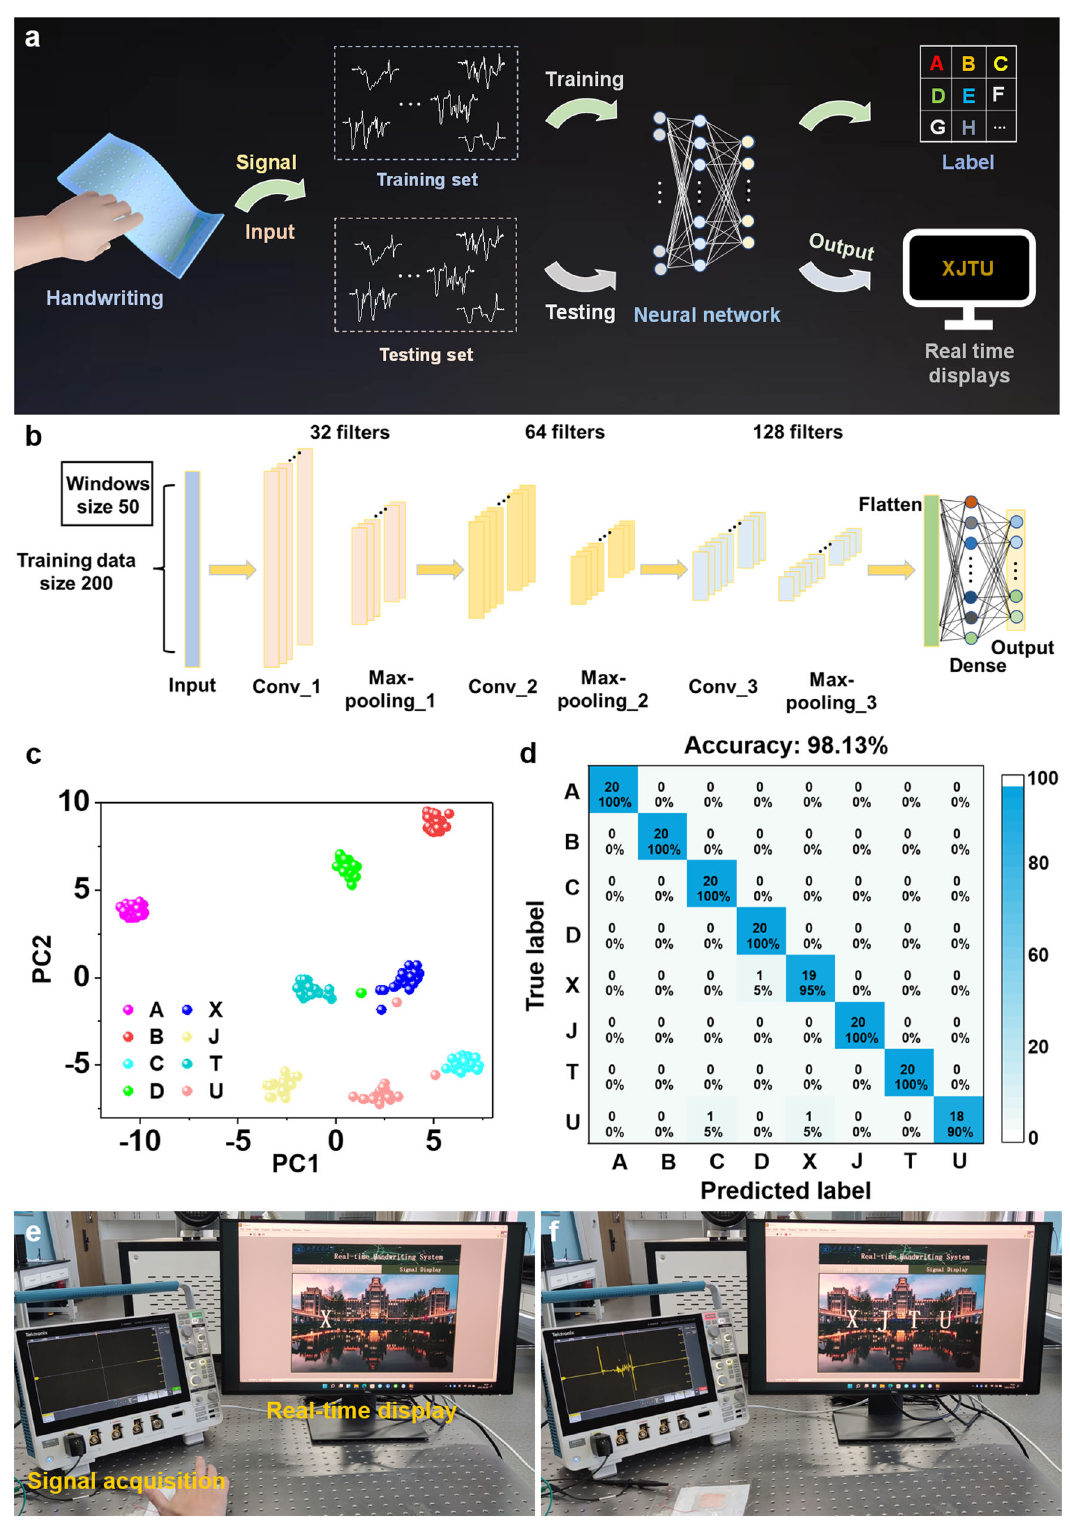
Fig. 5 Real-time handwriting system based on deep learning. a Flow-process diagram of the real-time handwriting system. b The detailed process and parameters of a CNN model. c Clustering results after processing the voltage signal of “ A, B, C, D, X, J, T, U ” by CNN model. d Confusion map of recognizing 8 letters. e , f Demonstration of writing down the four letters “ X-J-T-U ” with a fi nger on ME-skin and displaying these letters on LabVIEW section in